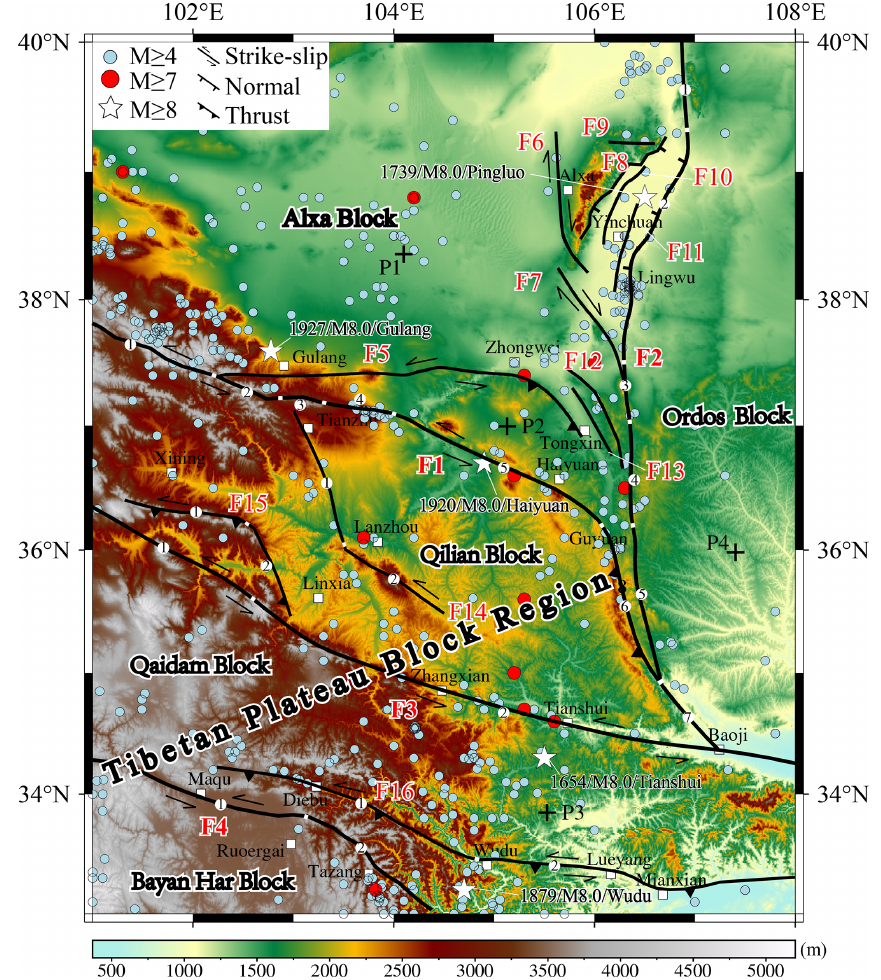
Figure 1. Map of active faults and earthquakes in the NETP. Black lines represent the active faults. The light blue and red dots and white stars represent earthquakes from 1831BCE to 2017CE from the National Earthquake Data Center (http://data.earthquake.cn, last access: 25 August 2022). Black crosses (P1–P4) indicate the locations of four test sites for comparison with the numerical model shown in Fig. 3b. Faults discussed in the text are labeled as follows: F1-1 is the Lenglongling fault, LLLF; F1-2 is the Jinqinaghe fault, JQHF; F1-3 is